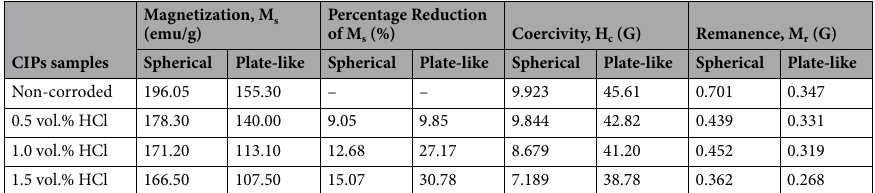
Table 2. Comparison of magnetic properties between different shapes of CIPs.